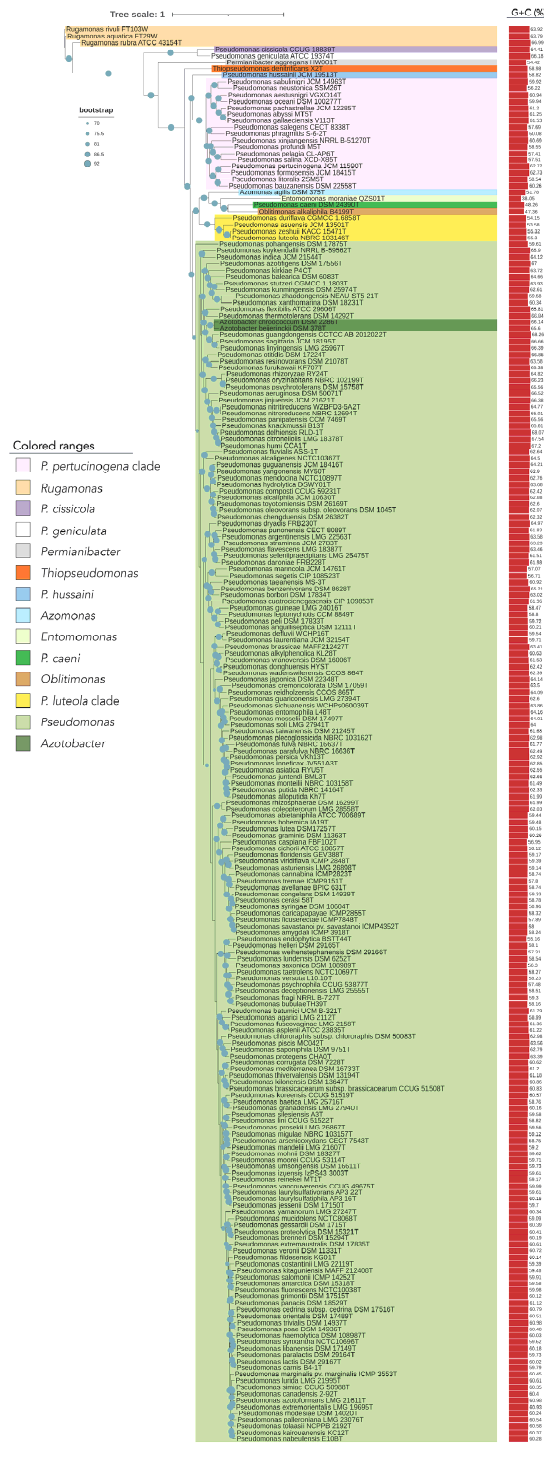
Figure 1. Phylogenomic tree of the Pseudomonadaceae type strains based on 92 concatenated house- keeping genes. The tree was built with UBCG, which uses MAFFT to create the multi-gene alignment and FastTree for computing the tree. Red bars represent GC (mol%) content for each genome. Blue circles represent bootstrap values, which indicate the number of individual phylogenetic trees of each of the 92 genes that support each branch (Gene Support Index). Bootstrap value of 92 means that the branch is supported by all UBCG